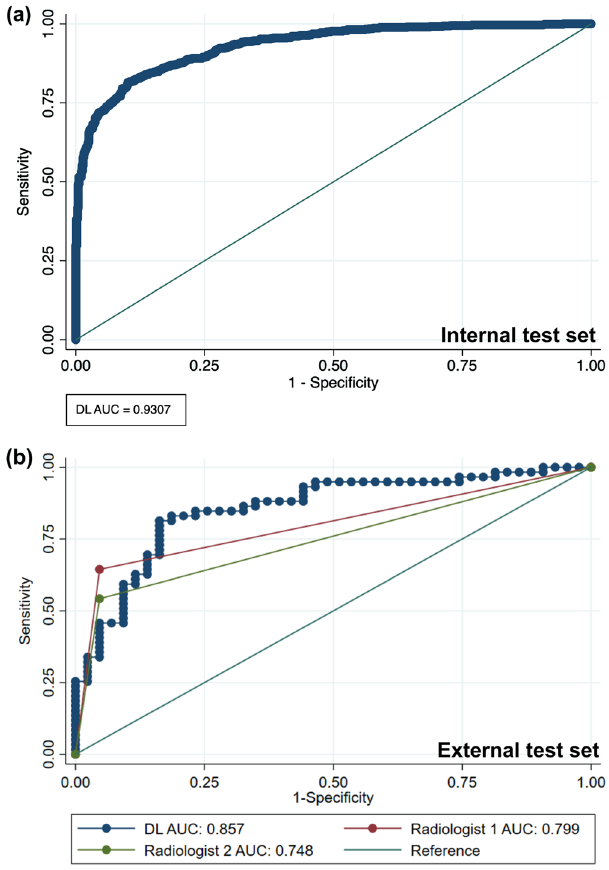
Figure 1. HYPERLINK "sps:id::fig1||locator::gr1||MediaObject::0" Receiver operating characteristics curves of the deep learning algorithm in the ( a ) internal test set and ( b ) external test set with radiologists.